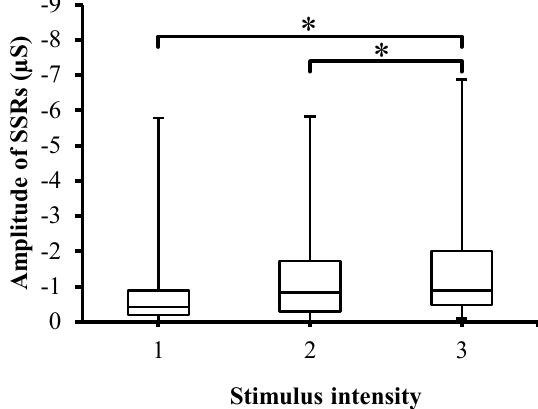
Fig. 3: Box-plot with medians, quartiles and the min and max as whiskers shows value of SSRs_Amp with respect to the stimulus intensity. * p <0.05.